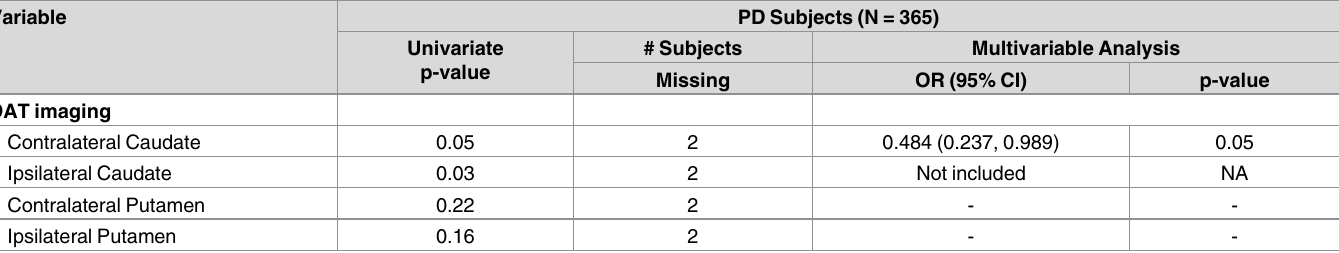
Table 5. Longitudinal biomarkerpredictors of investigator diagnosis of cognitive impairment.